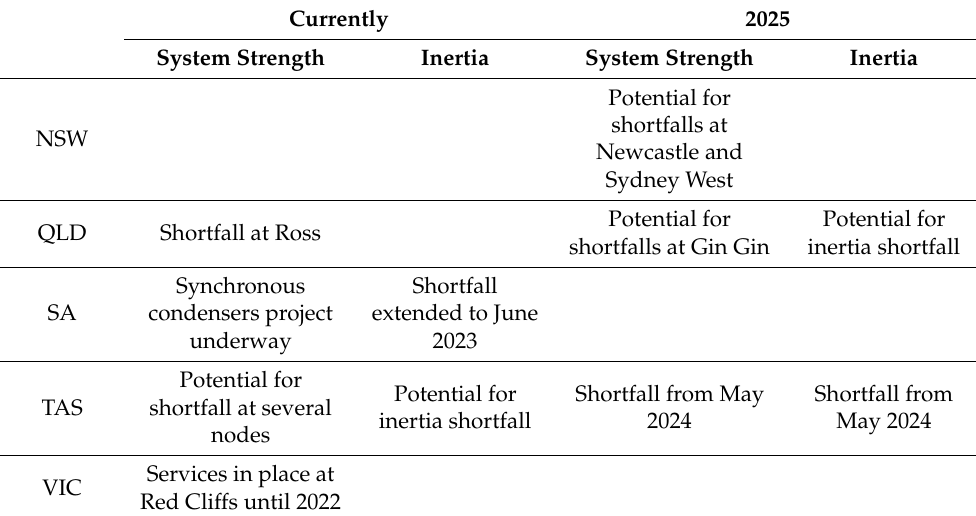
Table 4. Summary of system strength and inertia outcomes for 2020 in the NEM. Currently 2025 System Strength Inertia System Strength Inertia NSW